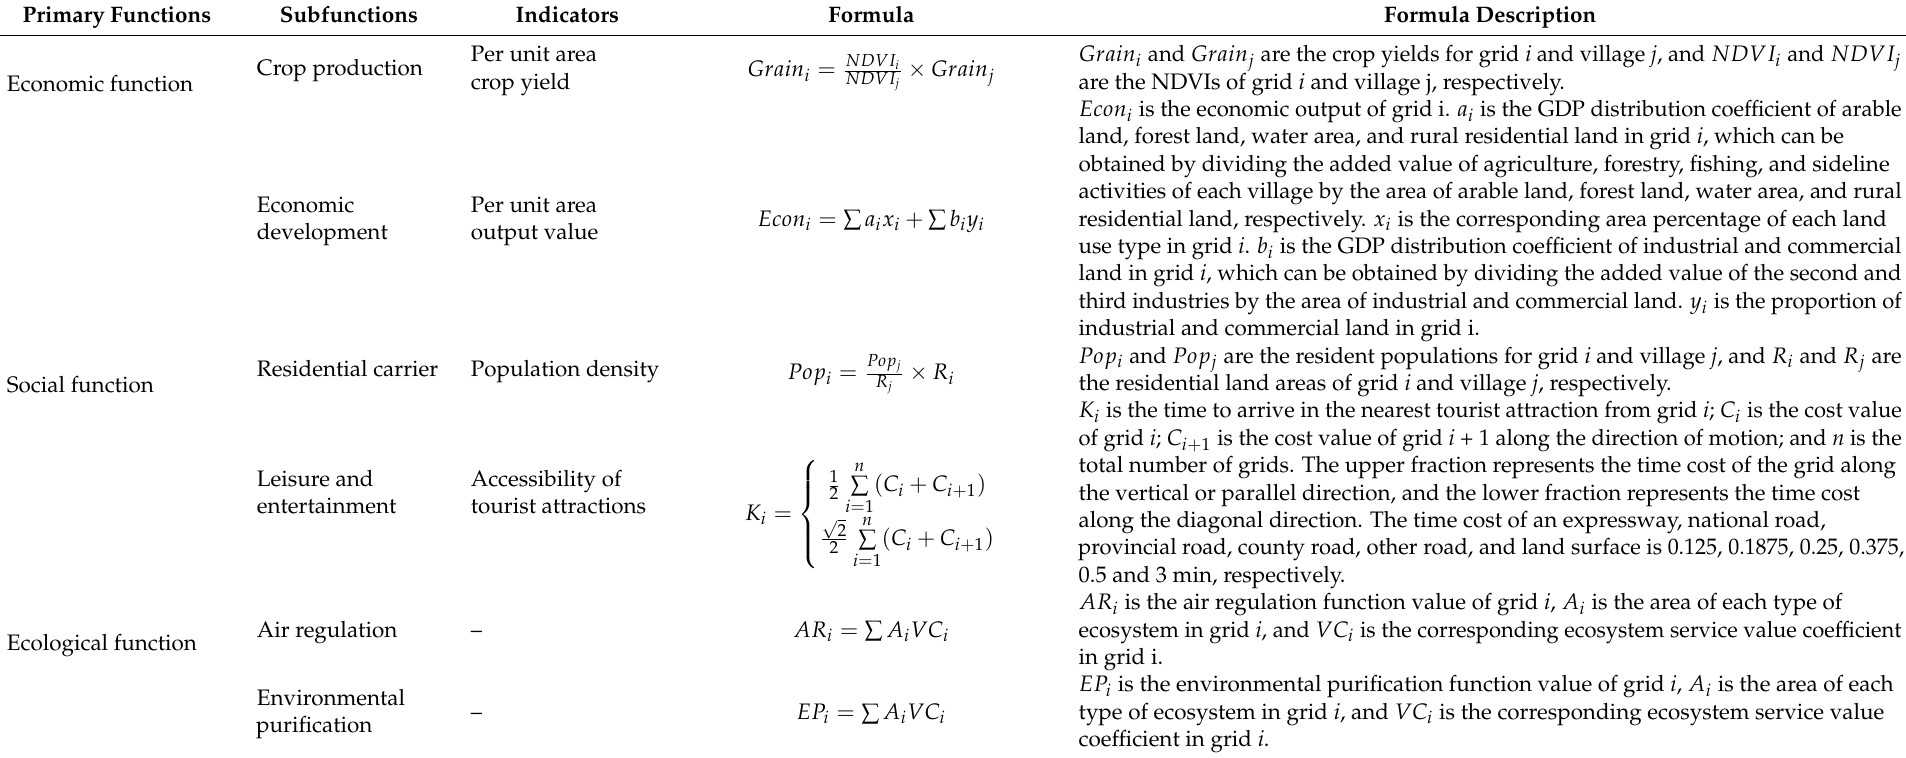
Table 1. Land use functions, indicators, and quantification